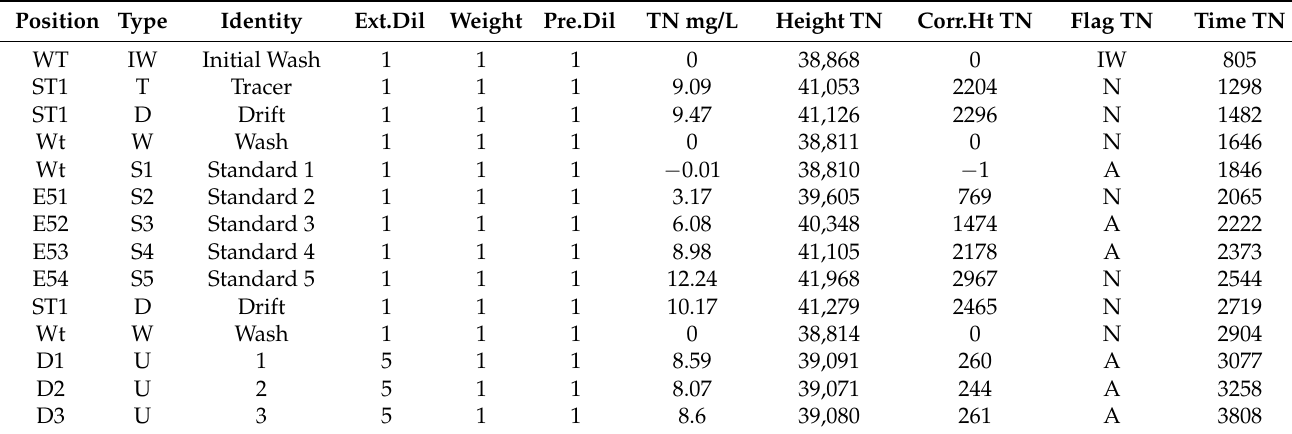
Table 1. Raw data generated by the CFA after detecting